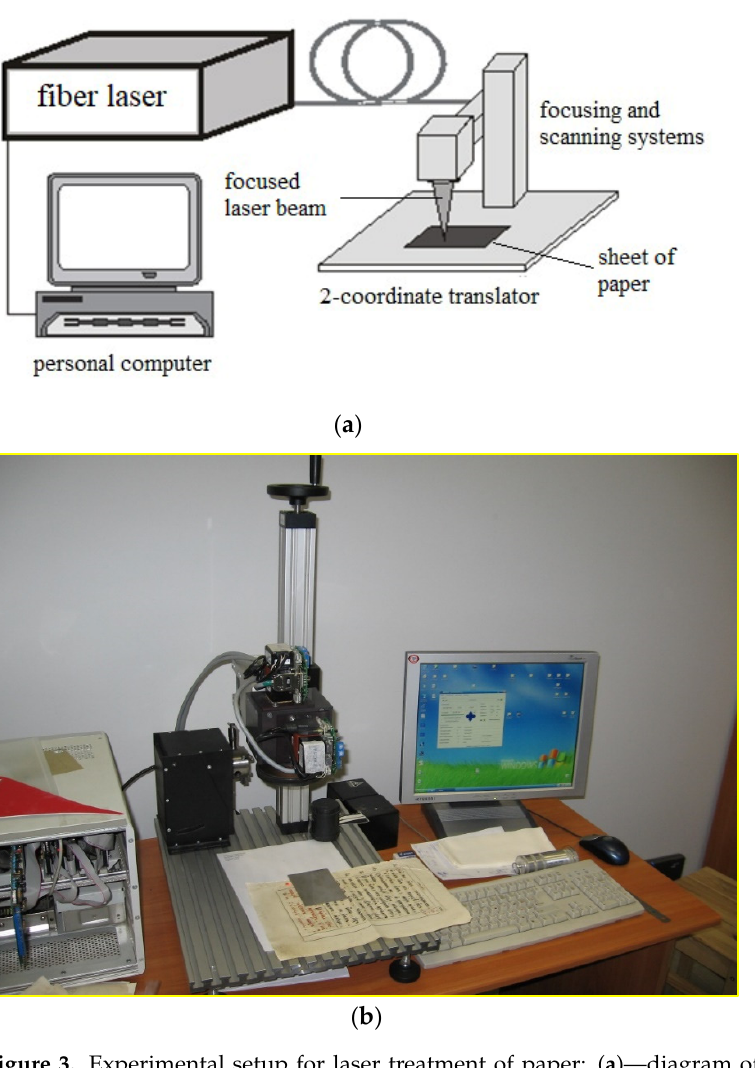
Figure 3. Experimental setup for laser treatment of paper: ( a )—diagram of experimental setup; ( b )—general view. Table 2. The effect of laser processing on the physical and mechanical properties of paper (index- fracture